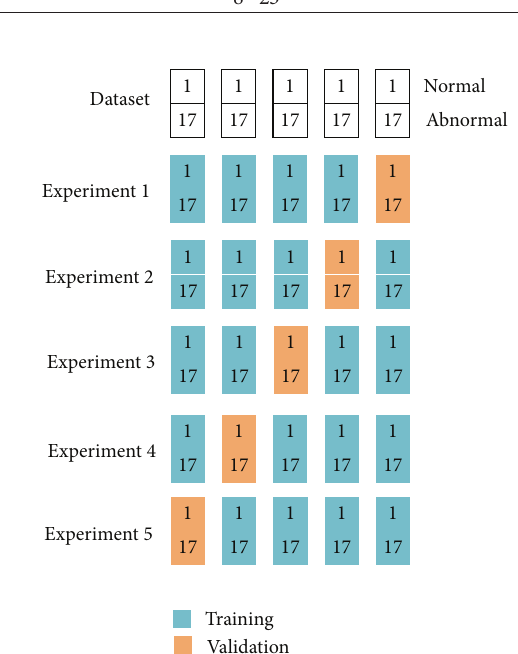
Figure 7: Illustration of 5-fold cross-validation of brain dataset (we divided the dataset into 5 groups, and for each experiment, 4 groups were used for training, and the rest one group was used for validation. Each group was used once for validation).